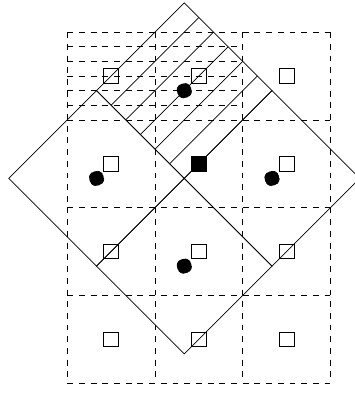
Fig. 2. Overlap of the land and sea masks. The diamond represents four grid points of the atmospheric model, denoted by the filled circles. The dashed rectangle represents twelve grid points of the ocean model, denoted with empty squares. The top grid point of the atmospheric model is a land point. The top and left points, indi- cated by dashed lines, are land points of the ocean model. The filled square is a water point for the ocean model, but a land point for the atmospheric